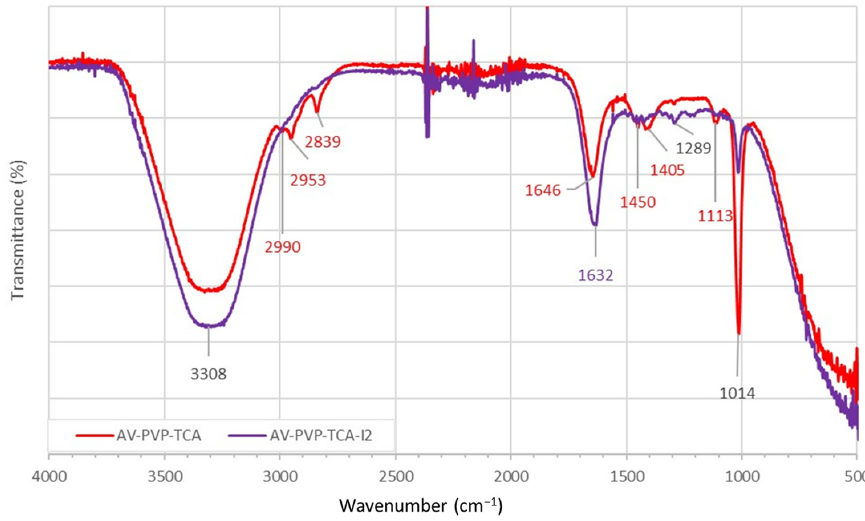
Figure 7. FTIR spectroscopic analysis from AV-PVP-TCA (red) and AV-PVP-TCA-I 2 (purple). The title compounds AV-PVP-TCA-I 2 and AV-PVP-TCA reveal a similar pattern in